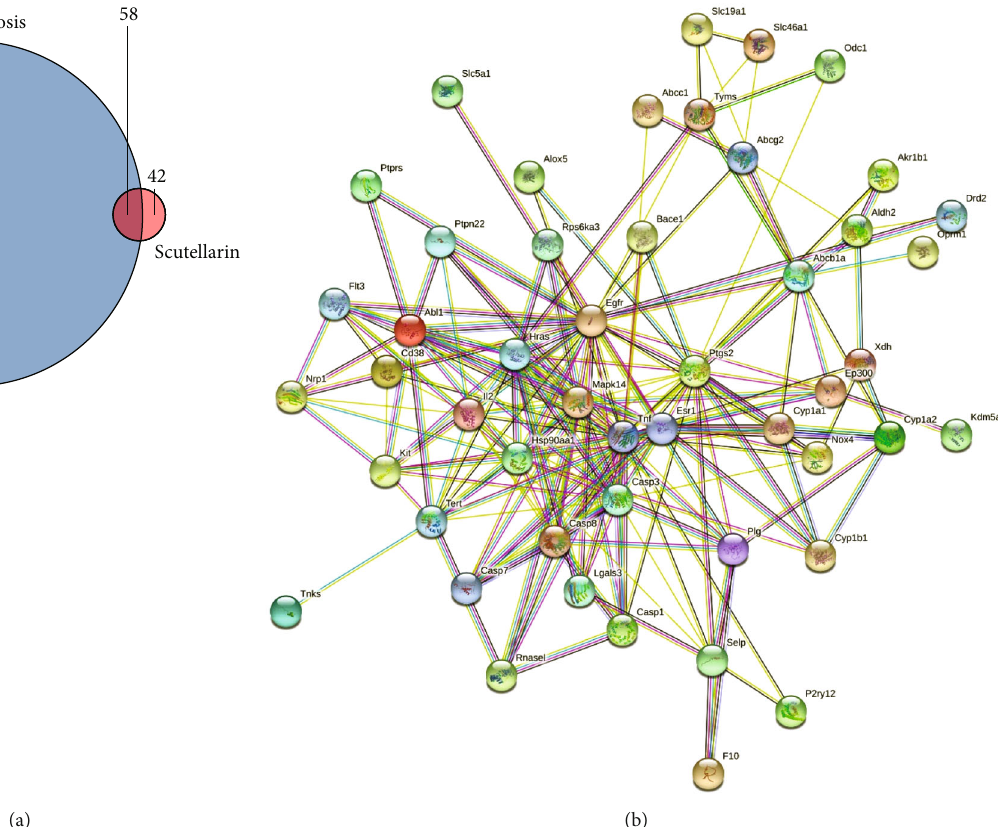
Figure 1: Target genes of scutellarin for the treatment of osteoporosis based on network pharmacology analysis. (a) Venn diagram of overlapped genes. (b) PPI network of overlapped